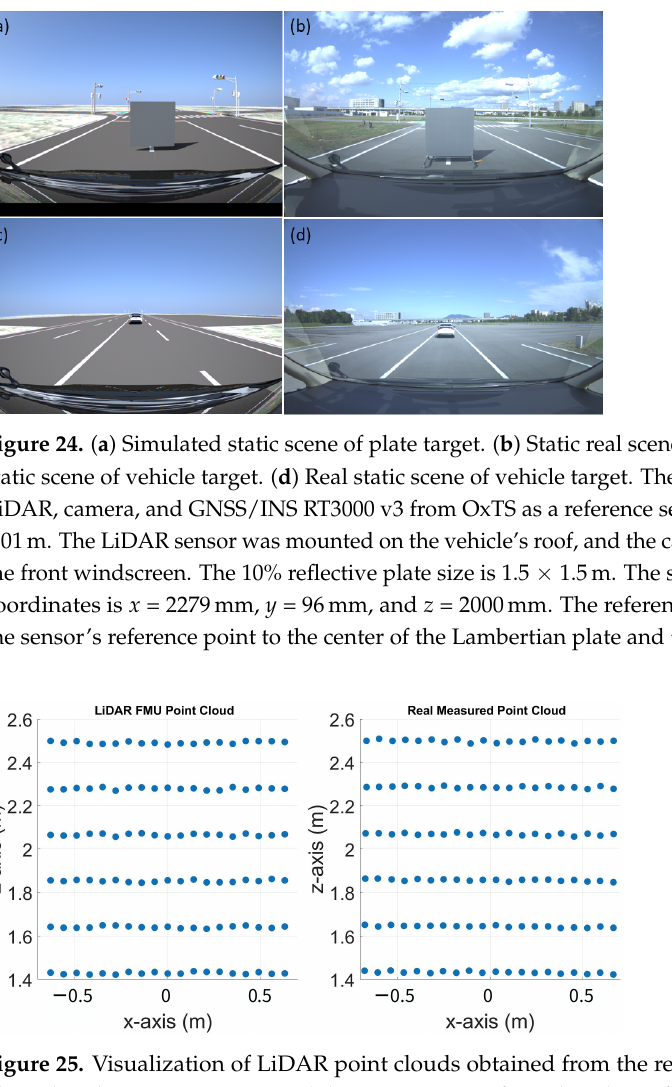
Figure 23. Sunlight intensity is measured on a cloudy day. The intensity of sunlight was recorded with an ADCMT 8230E optical power meter in W, and the sensor window size in m 2 is used to calculate the sunlight intensity in W/m 2 .